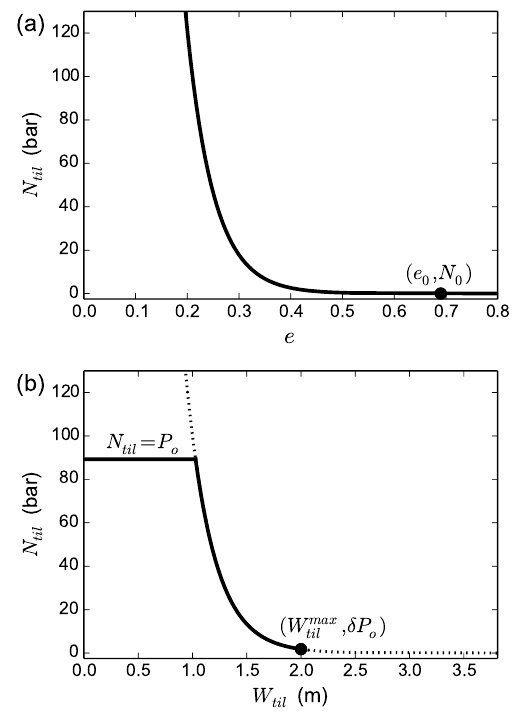
Figure 1. (a) Equation (19) determines the effective pressure N til as a function of the void ratio e ; reference values e 0 , N 0 are indicated. (b) The same curve, but with N til as a function of W til , with bounds above by overburden pressure P o and below by a fixed fraction δ of P o ; the solid curve is used in our model. The case shown has 1000 meters ice